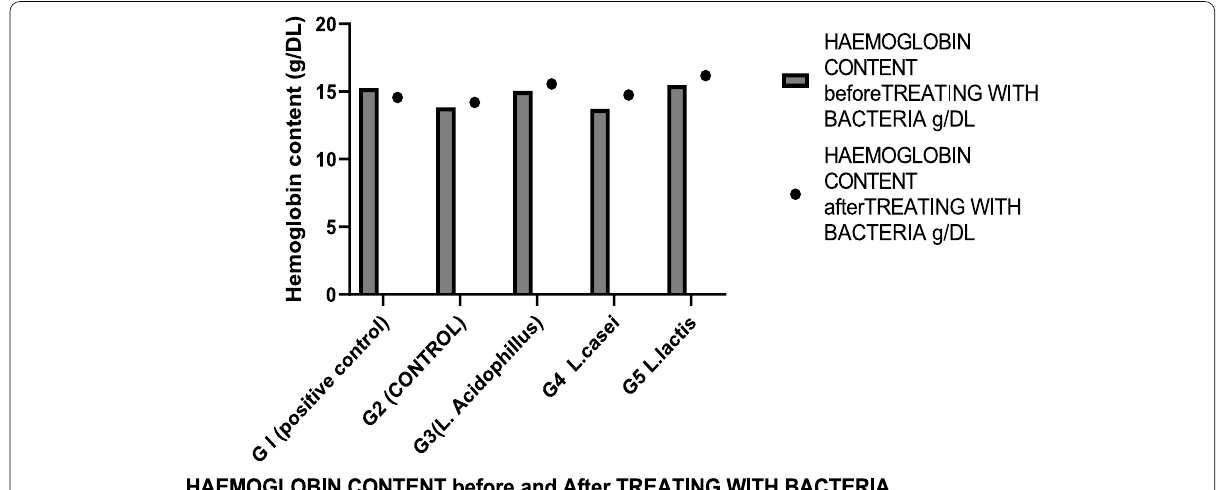
Fig. 3 Represent hemoglobin content (g/DL) in mice fed with Lactobacillus